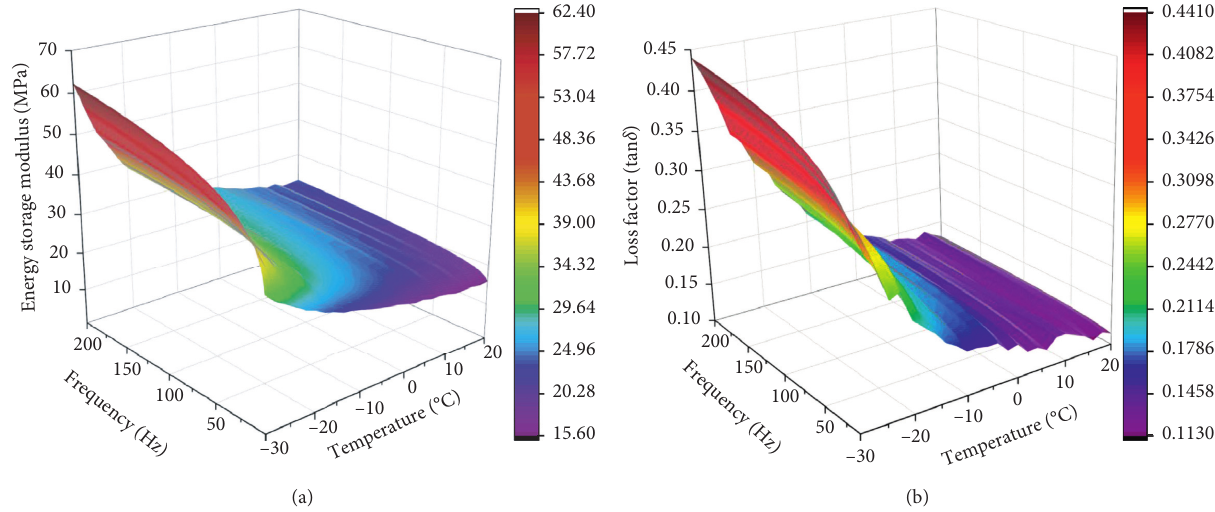
Figure 9: Three-dimensional diagram of viscoelastic dynamic characteristics of rubber pad under rail: (a) energy storage modulus; (b) loss factor. Table 2: Parameters of CRH380A high-speed train. Parameters